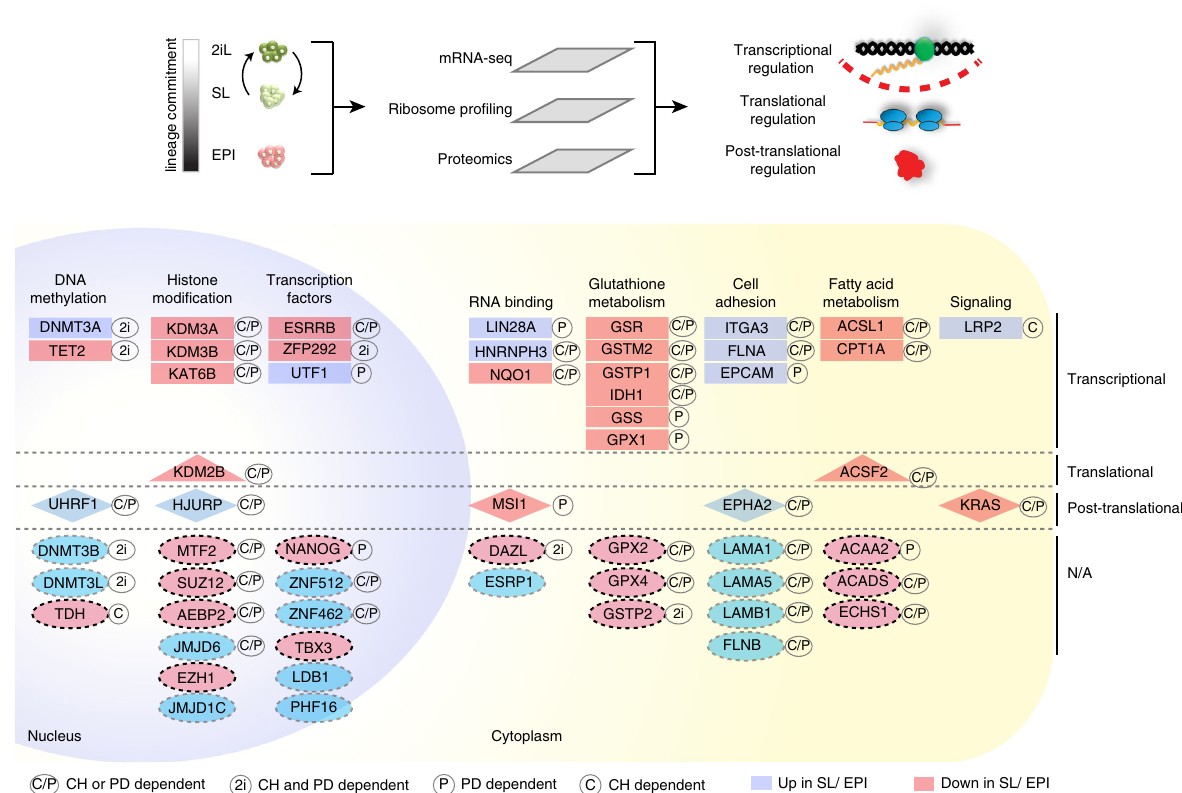
Fig. 6 Diverse modes of gene regulation in pluripotent cells. An overview of the multiple layers of gene regulation that have been integrated in this study. Examples of genes that undergo speci fi c regulation at the transcriptional, translational, or post-translational levels are shown. Genes that could not be assigned to any speci fi c mode of gene regulation (e.g. because the RFP, RNA, or protein could not be uniquely integrated in different conditions) are indicated with NA. Genes were also assigned to signaling pathways downstream of CH or PD, as indicated in the fi gure. “ C/P ” refers to the proteins that require either PD or CH to maintain expression similar to 2iL ESCs; only removing both inhibitors from 2iL induces changes resembling the SL/EPI states. “ 2i ” refers to the proteins that require both PD and CH signaling to maintain expression similar to 2iL state; removing either PD or CH from 2iL induces changes similar to SL/EPI state. “ P ” refers to the proteins that require PD to maintain an expression pattern similar to 2iL; removing PD from 2iL medium induces changes similar to SL/EPI state. “ C ” refers to the proteins that require CH to maintain an expression pattern similar to 2iL; removing CH from 2iL medium induces changes similar to SL/EPI